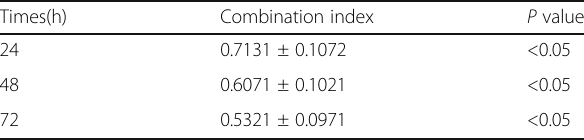
Table 1 Analysis of the interaction between the inhibition effect of ASMq in combination with 5-fluorouracil on cell growth